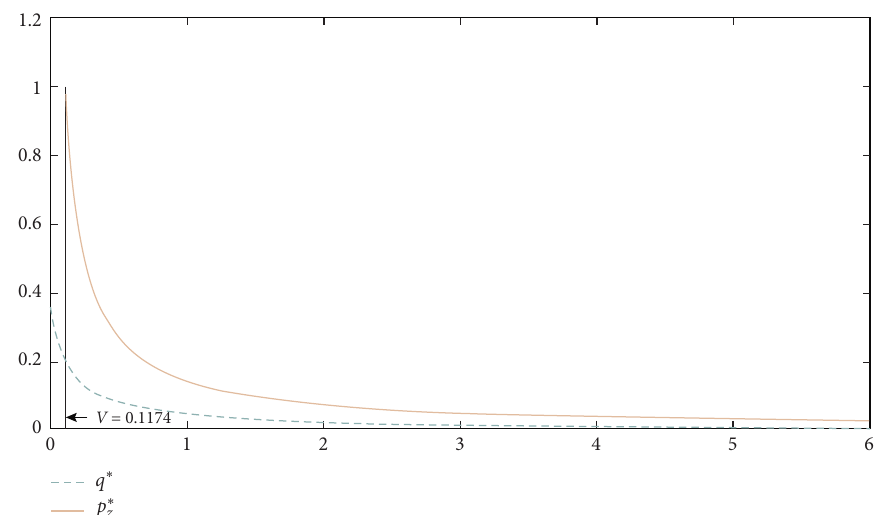
Figure 8: Simulation diagram of the influence of government agent salary on optimal rent-seeking probability and optimal supervision